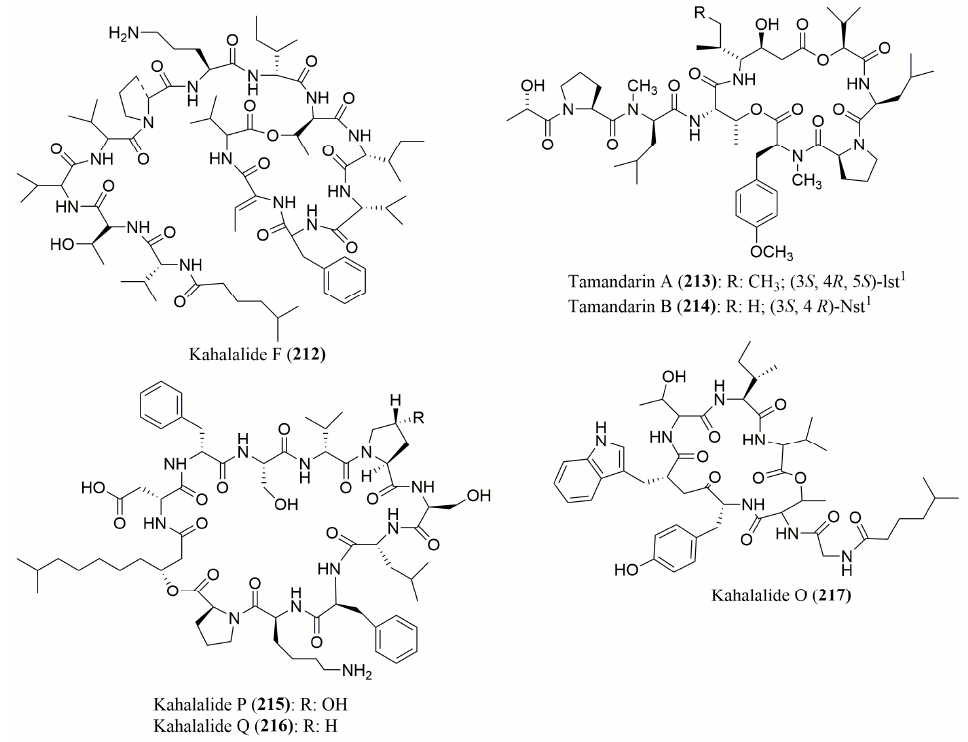
Figure 16. Structure of cyclic depsipeptides 207 – 217 , isolated from marine invertebrates and marine algae. Table 10. Cyclic depsipeptides from marine invertebrates and algae.